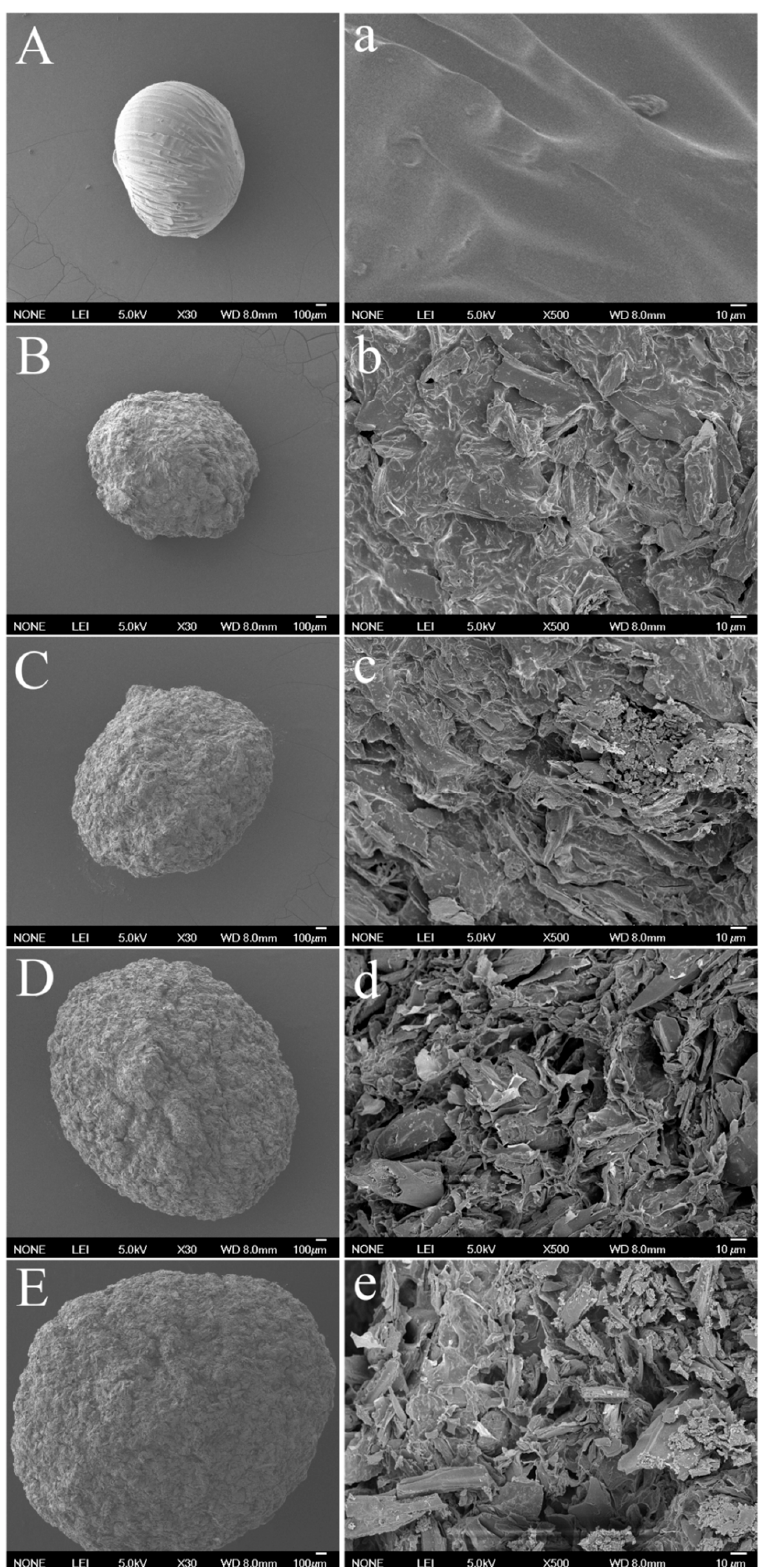
Figure 2. SEM images of pectin microsphere ( A , a ), P/AC 4:1 ( B , b ), P/AC 2:1 ( C , c ), P/AC 1:1 ( D , d ), and P/AC 2:3 ( E , e ). The capital letters represent the whole view of microspheres, and the lower-case letter represents the enlarged surface of microspheres.